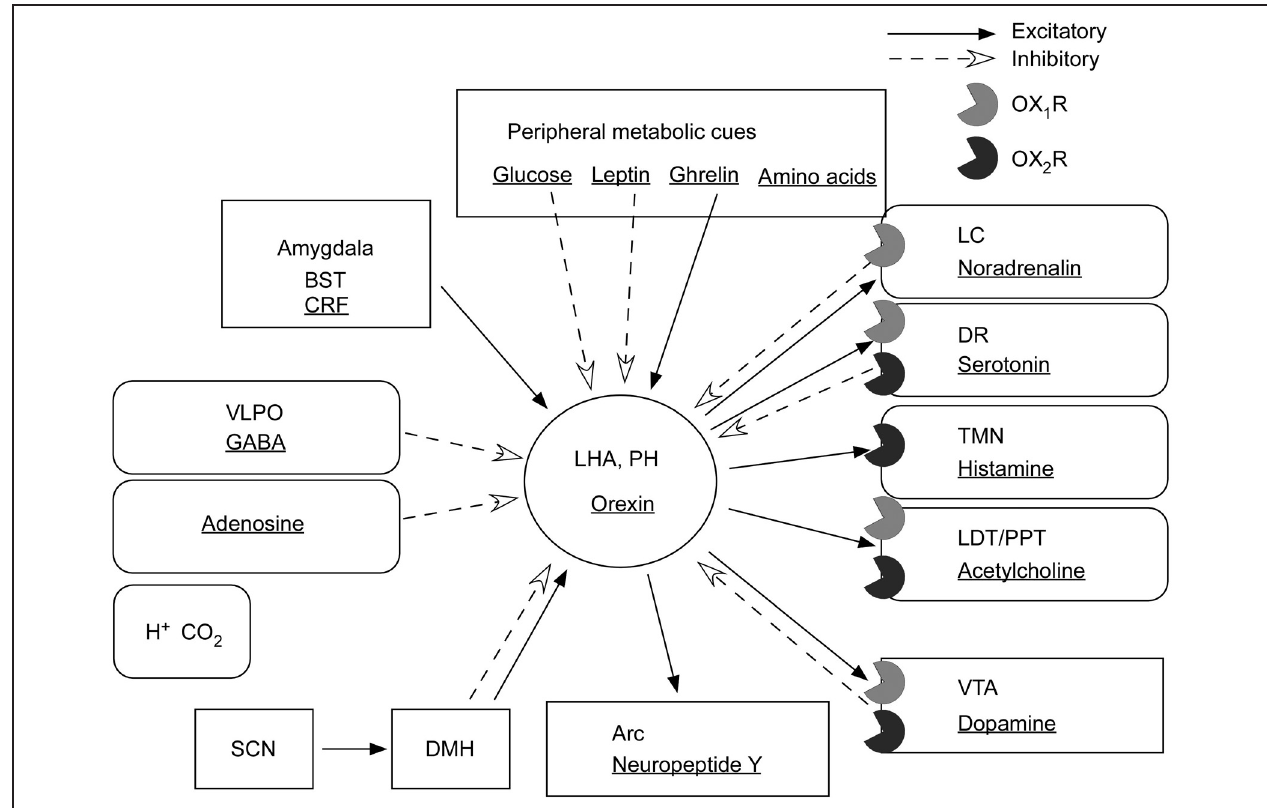
FIGURE 4 | Input and output of orexin neurons at interface of sleep, stress, reward, and energy homeostasis. Orexin neurons in the lateral hypothalamic area (LHA) and posterior hypothalamus (PH) are placed to provide a link between the limbic system, energy homeostasis, the brain stem, and other systems. Arrows show excitatory projections and broken arrows inhibitory projections. Gray semicircles indicate OX 1 R and black semicircles indicate OX 2 R. Neurotransmitters/modulators are underlined. LC, DR, and TMN are wake-active regions, VLPO is sleep-active region, and LDT/PPT is REM-active region. Orexin neurons promote wakefulness through monoaminergic nuclei that are wake-active. Stimulation of dopaminergic centers by orexins modulates reward systems (VTA). Peripheral